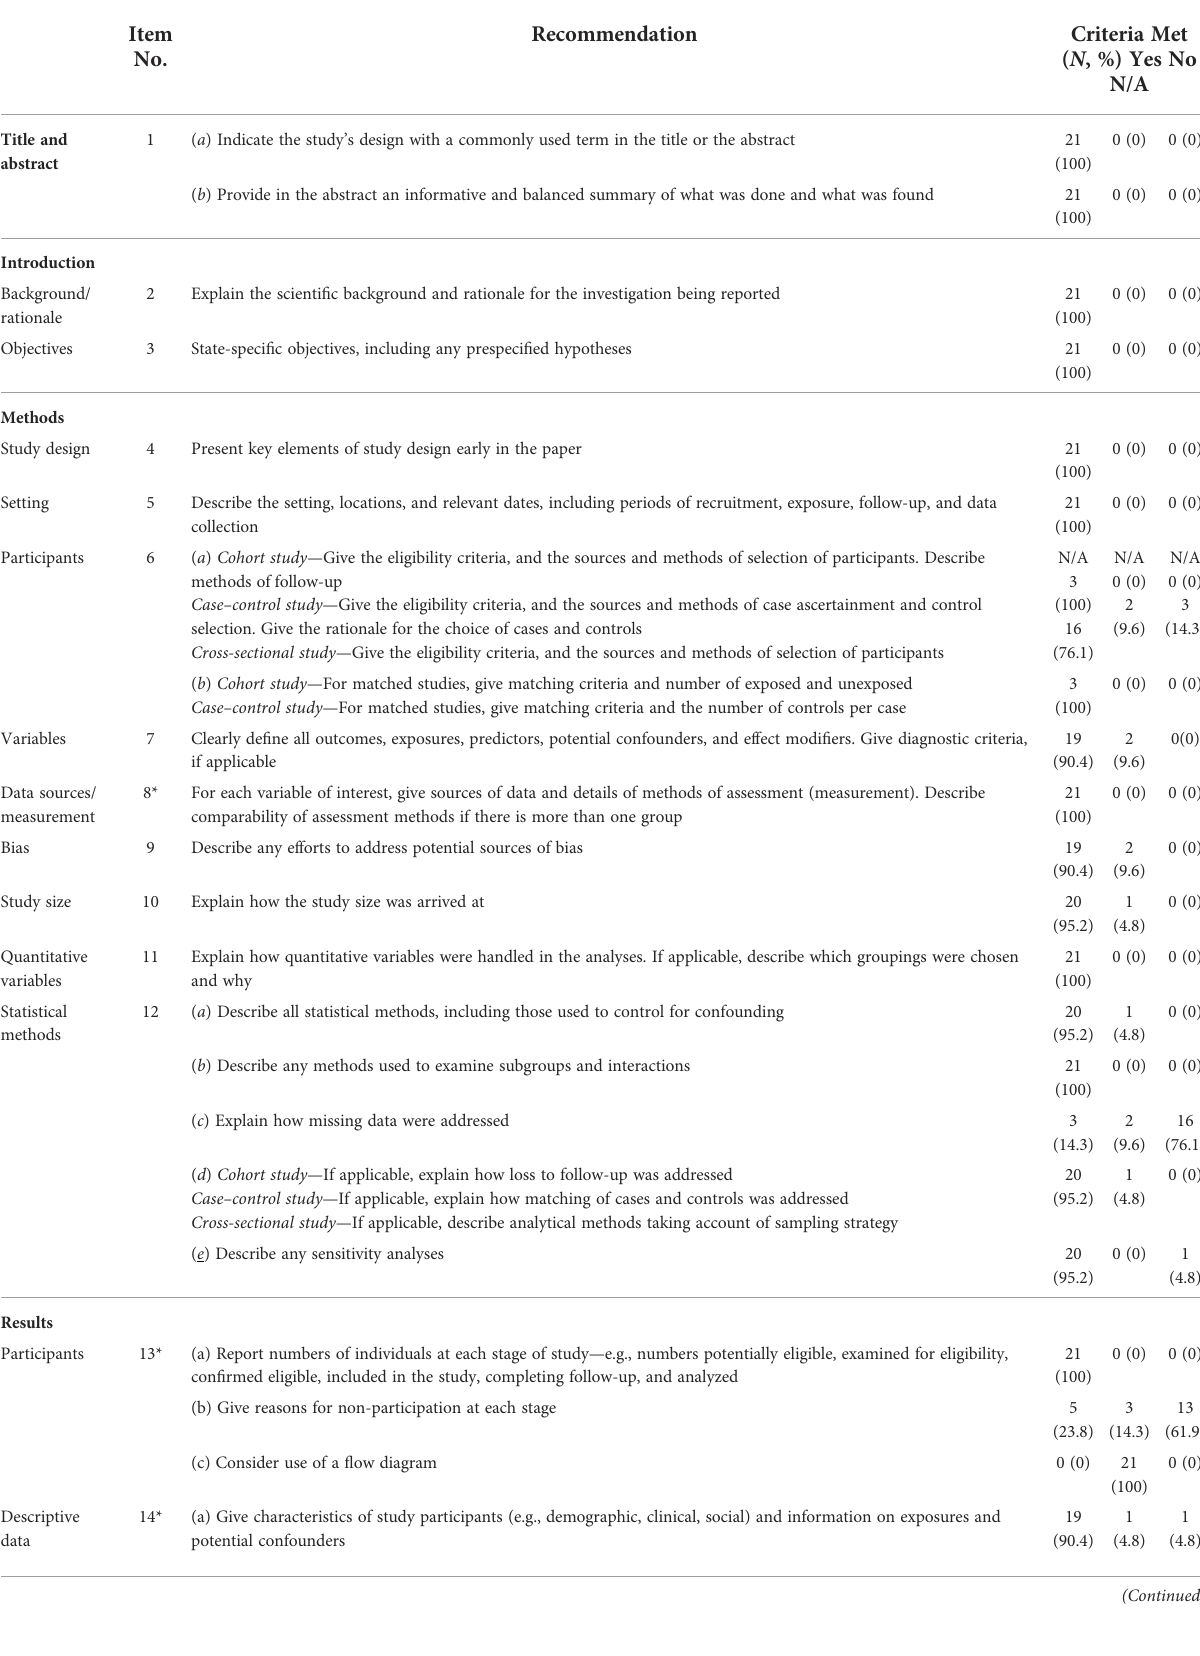
TABLE 4 STROBE Statement — A checklist of items and the completeness of reporting score (COR %) for the included studies ( n = 21). Item